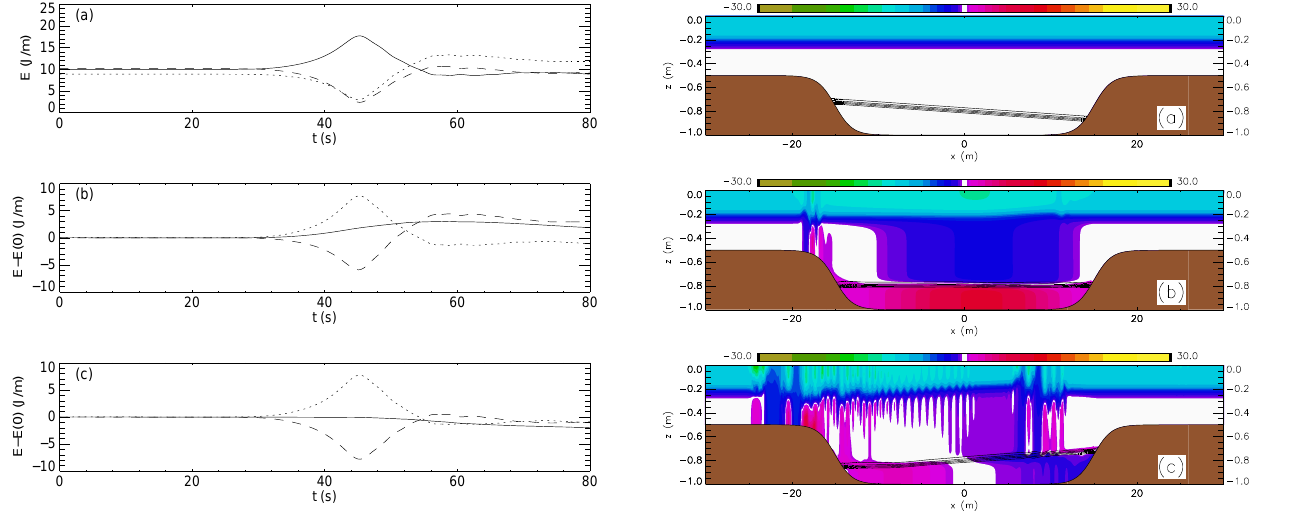
Fig. 13. Energetics for a shoaling ISW undergoing reflection. (a) Solid curve: ¯ E a . Dots: ¯ E kp . Dashed: ¯ E k2 . (b) Dots: ¯ E ¯ E ¯ E − ¯ E a − a ( 0 ) . Dashed: kp kp ( 0 ) . Solid curve: their sum. (c) Dots: ¯ E a − ¯ E a ( 0 ) . Dashed: ¯ E k2 − ¯ E k2 ( 0 ) . Solid curve: their sum.